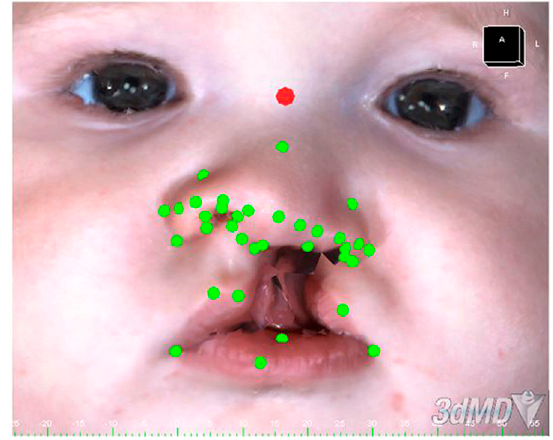
Figure 1. Three-dimensional acquisition of the face with anthropometric points. 73